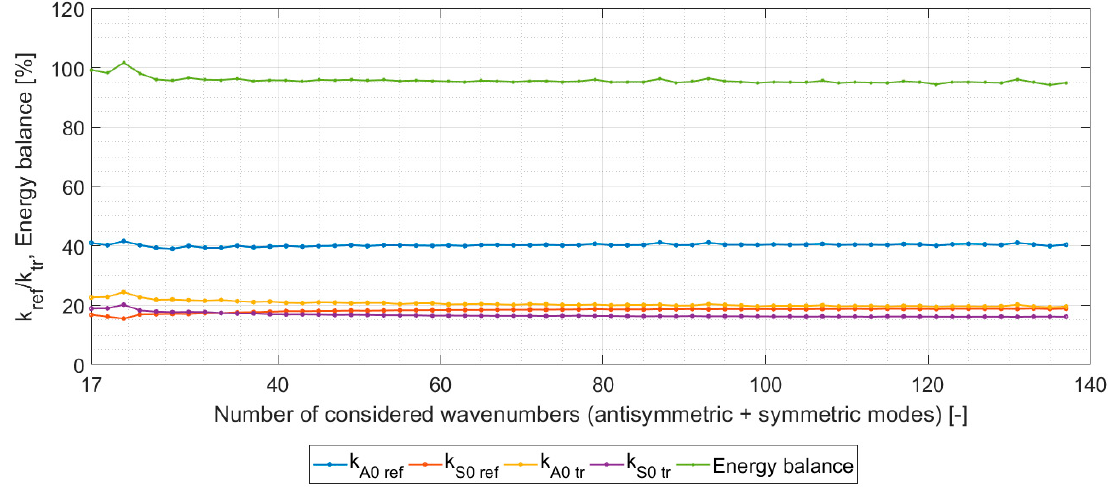
Figure 8. Numerical convergence of energy scattering coefficients in waveguide 1 (2.3% of reflected energy in sub-wave- guide 3).